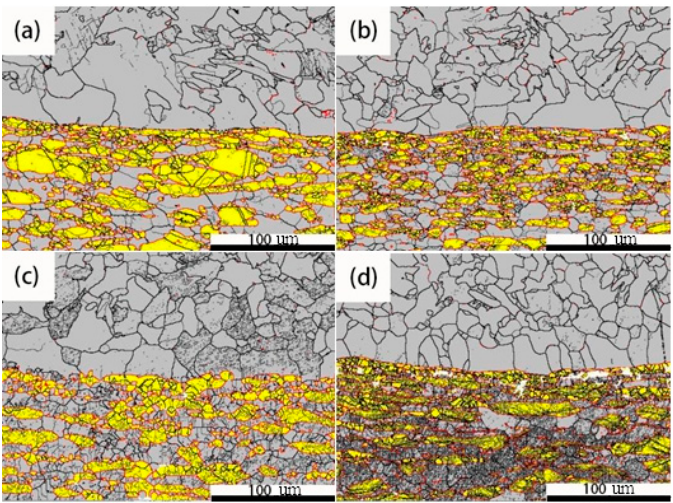
Figure 8. Phase boundary and grain boundary diagrams of large deformation regions at different rates at 1000 °C. ( a ) 0.01 s − 1 ; ( b ) 0.1 s − 1 ; ( c ) 1 s − 1 ; ( d ) 10 s − 1 .